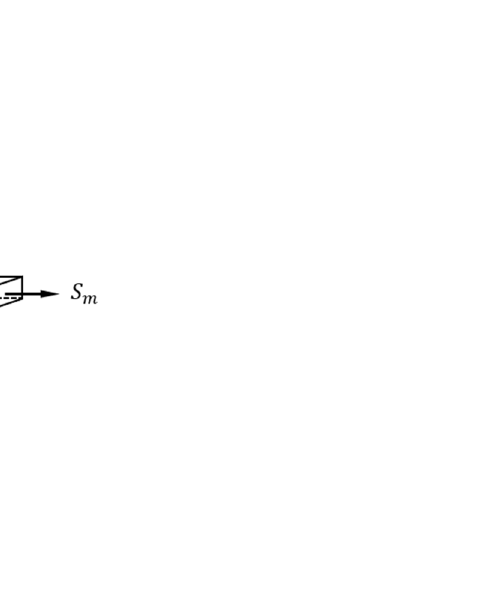
Figure 17. Distribution of stress contributing to diagonal tension strength for strengthened prisms.